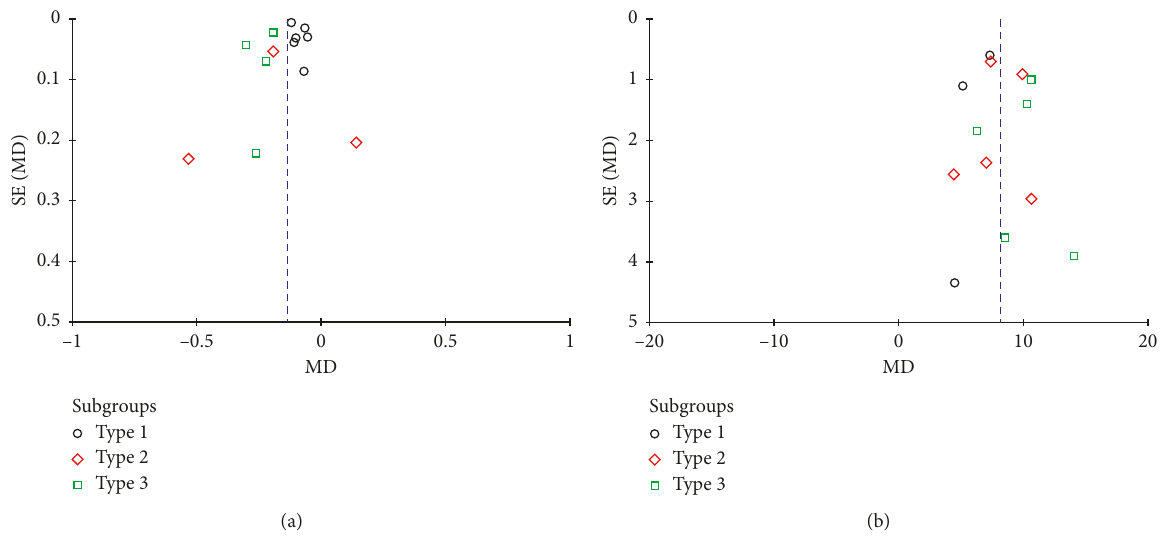
Figure 5: Funnel plots for short-term (a) and long-term (b) vision improvement